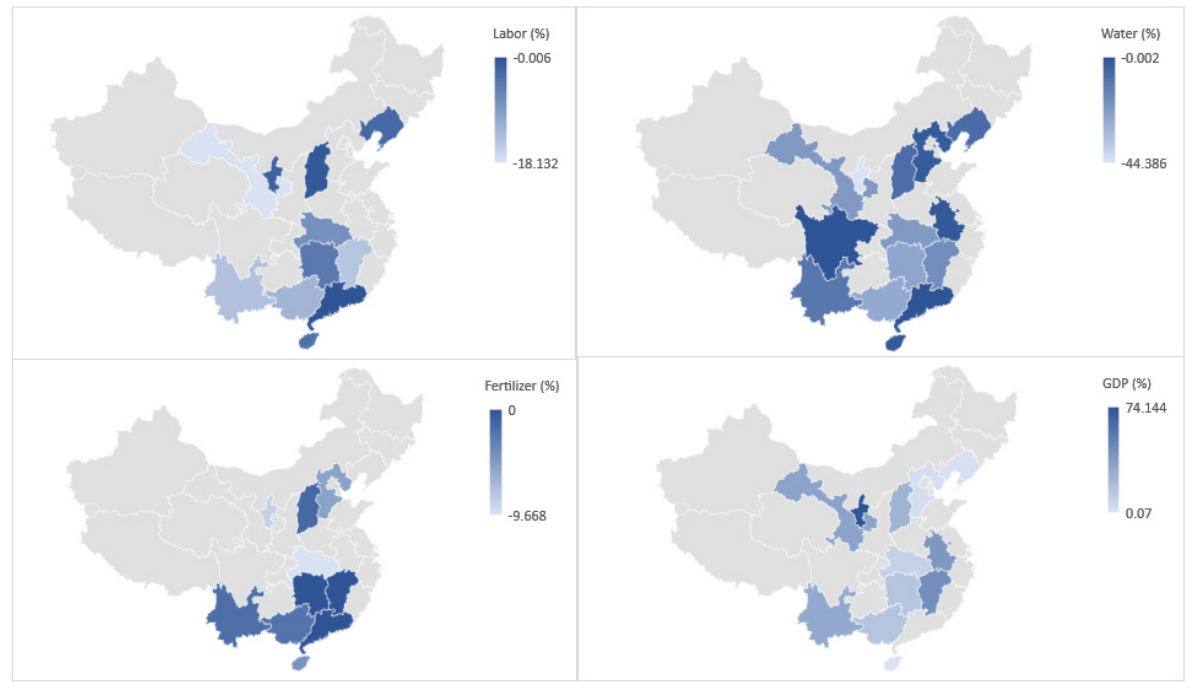
Figure 7. Areas where inputs and outputs need to be